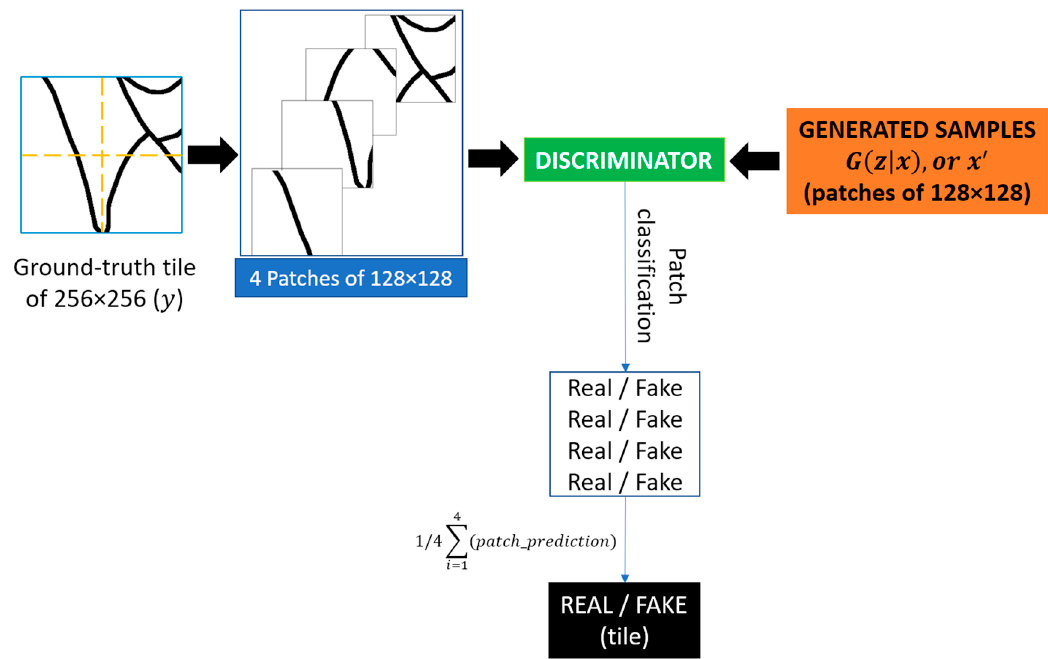
Figure 5. Analysis of the input data distribution with the proposed discriminator D (estimation of the probability that the input is real).